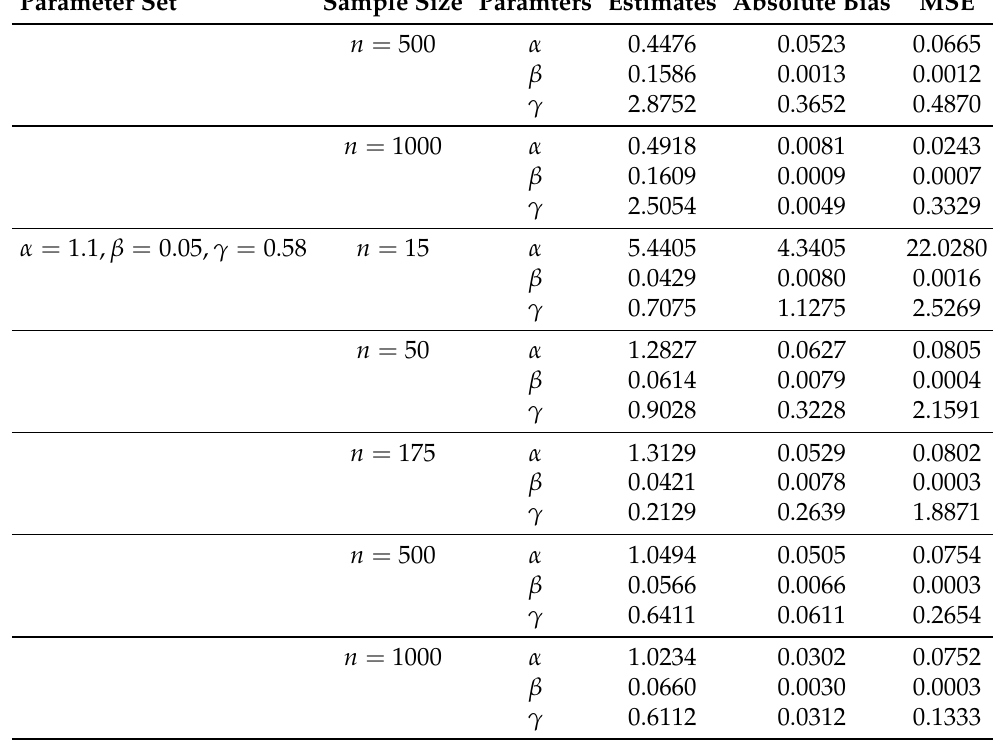
Table 2. Cont . Parameter